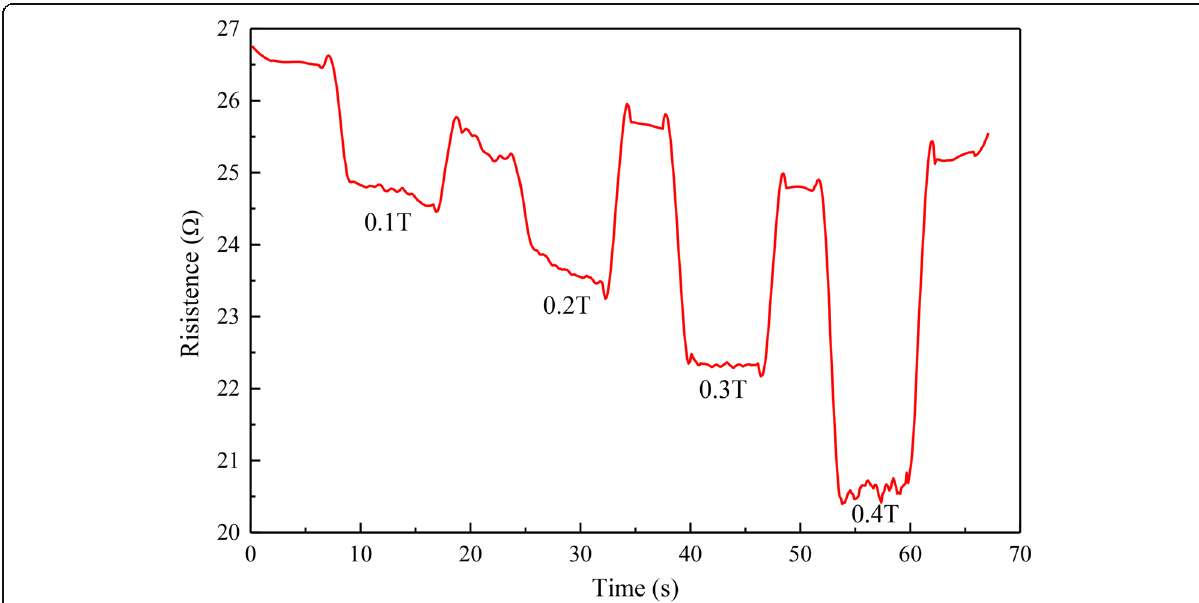
Fig. 8 The relationship between resistance and different magnetic